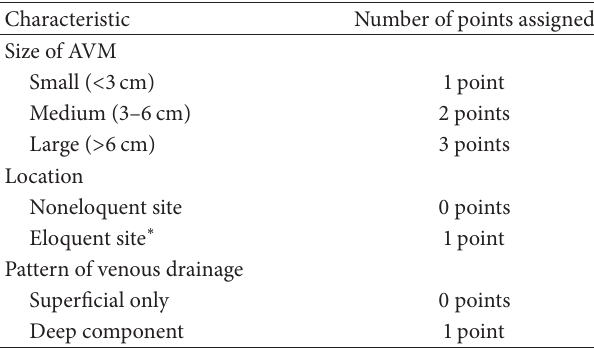
Table 1: Spetzler-Martin Grading Scale for